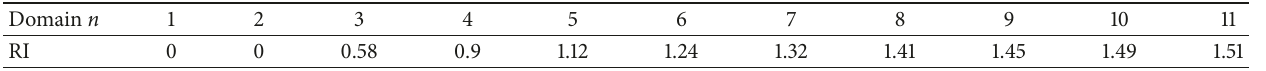
Table 3: Value of RI for different domains.